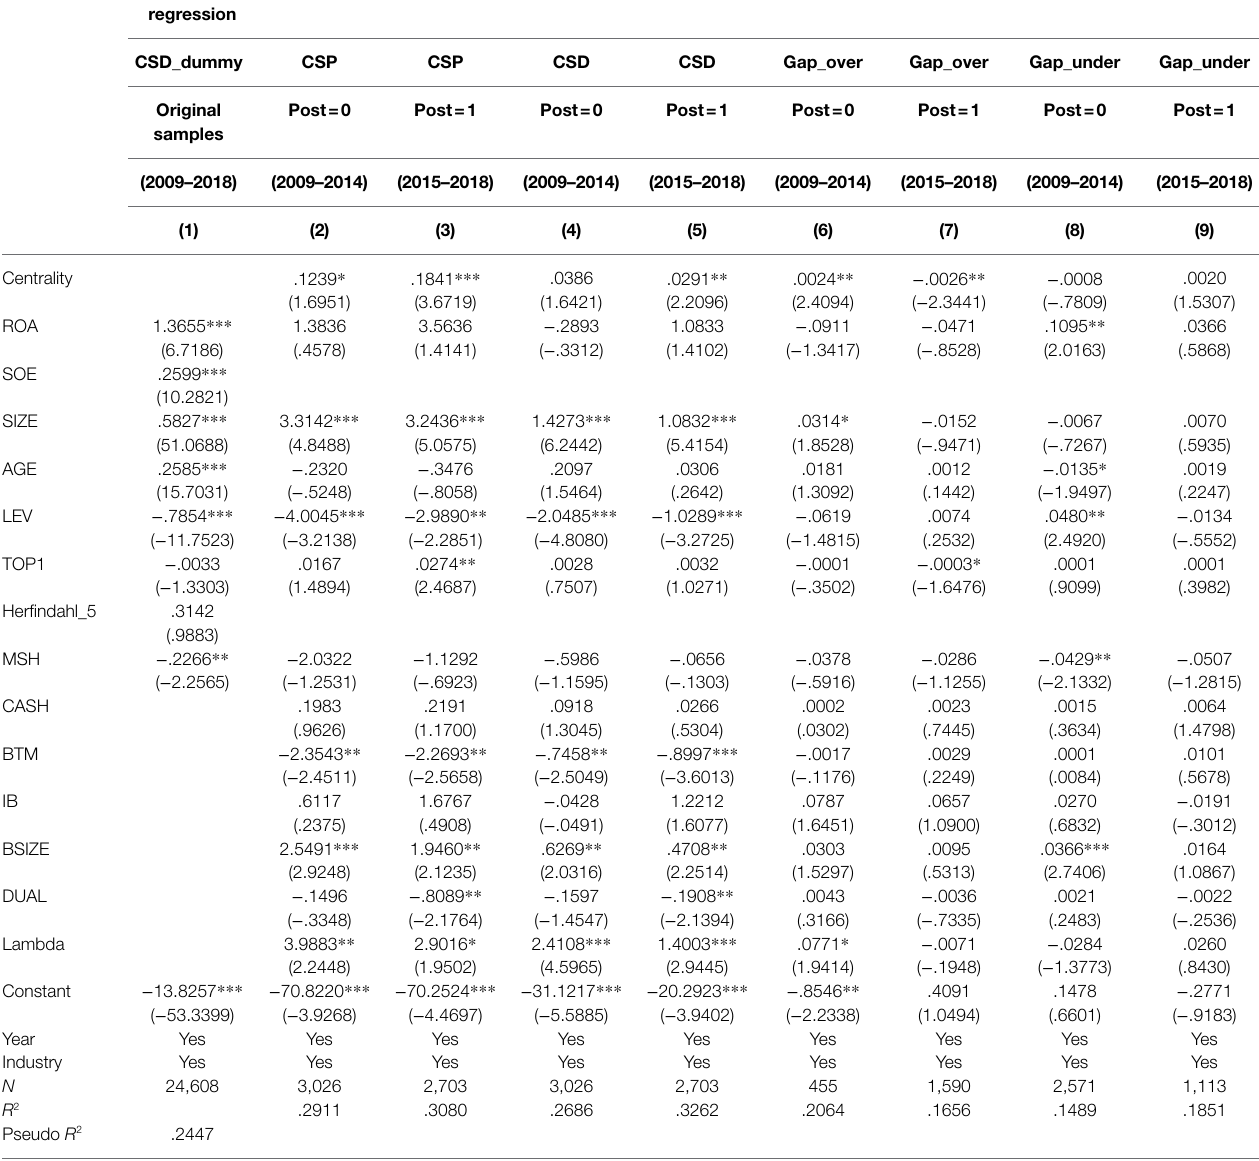
TABLE 5 | Results of Heckman’s